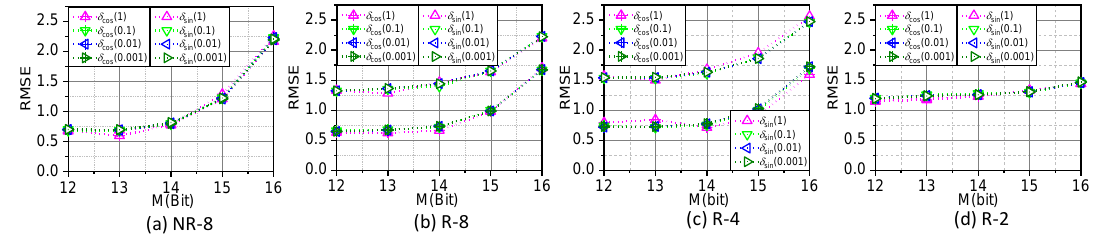
Figure 6. The relations between maximum absolute errors (MAEs) and the input bit width M of the NR-8, R-8, R-4 and R-2 CORDIC algorithms. The angles θ change from 0 to 90° in steps of 1, 0.1, 0.01 and 0.001°.